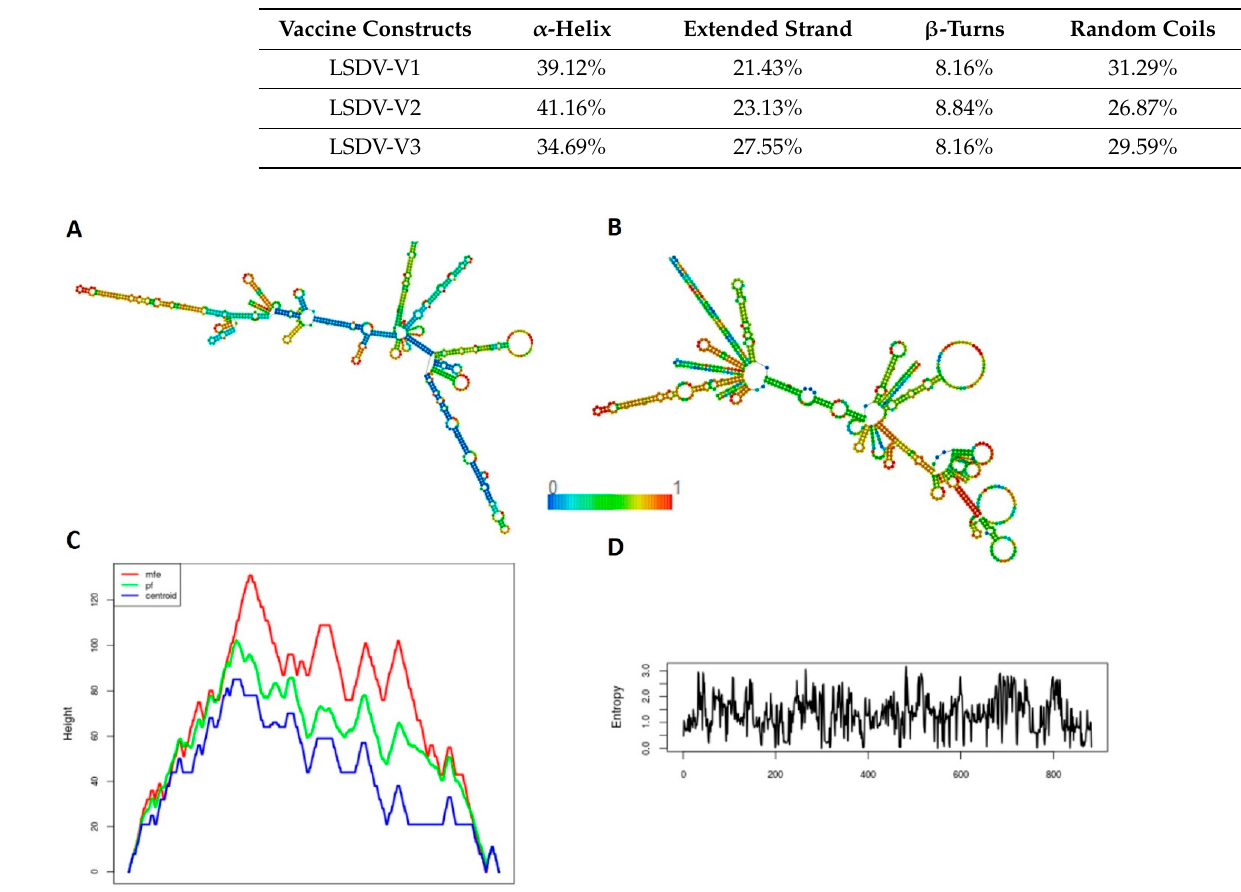
Table 5. The secondary and tertiary structure prediction and structural validation of the vaccine constructs.